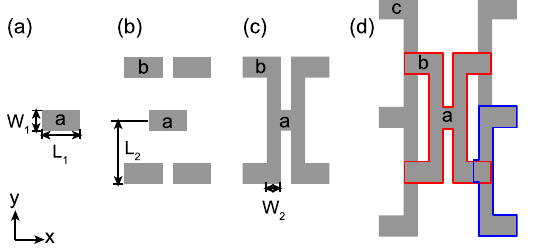
Figure 1. Schematics of ( a ) the single antenna element, ( b ) the disconnected pentamer, ( c ) the first and ( d ) second generation of dendritic antennas. The red and blue outlines in ( d ) indicate the first generation in ( b ) and an appended half of it respectively.